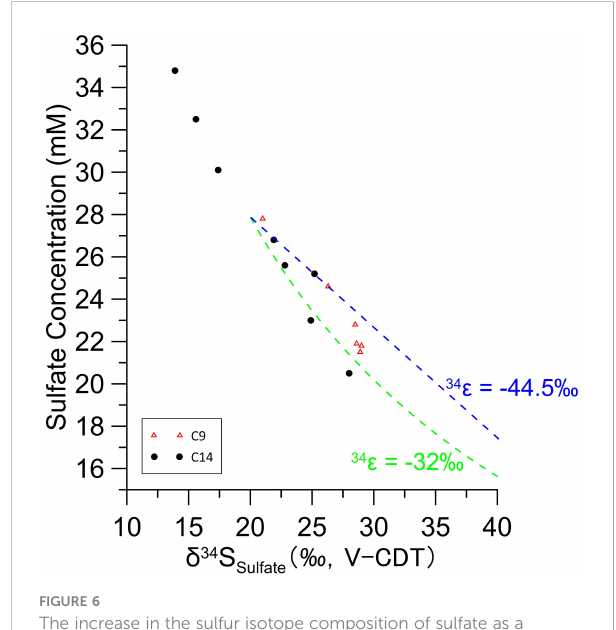
FIGURE 6 The increase in the sulfur isotope composition of sulfate as a function of the decrease in pore fl uid sulfate